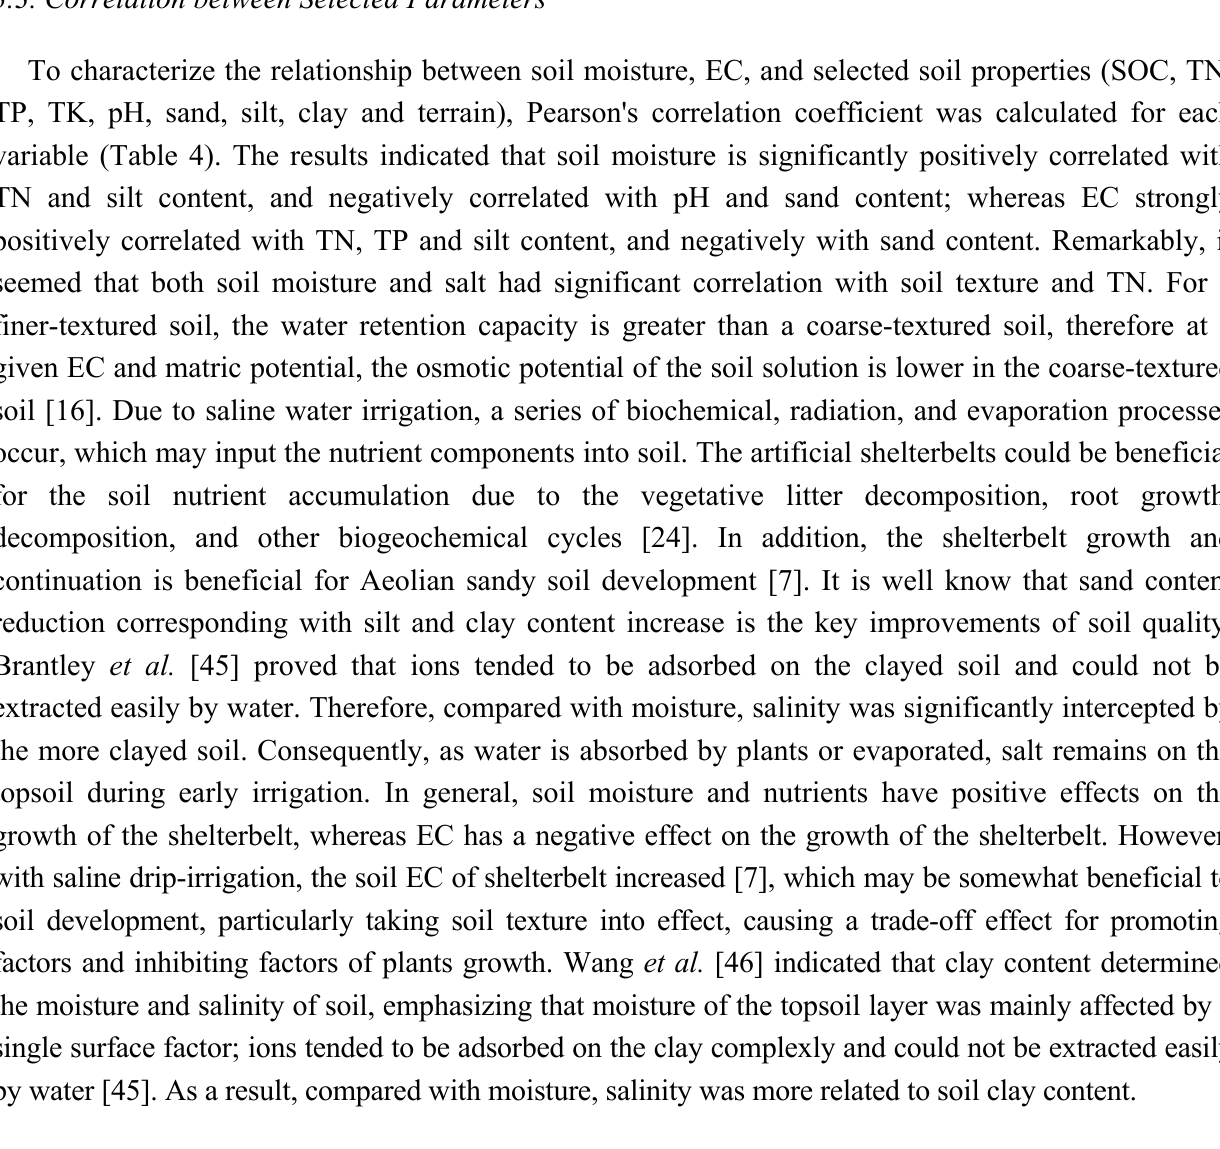
Table 4. Correlation coefficients between soil salinity and environmental